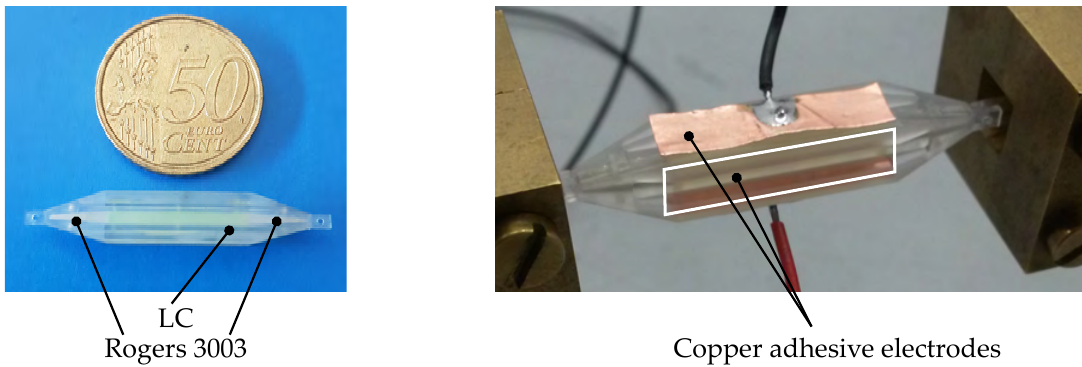
Figure 23. Cross section of the step-index fiber phase shifter with the LC cavity highlighted in red.